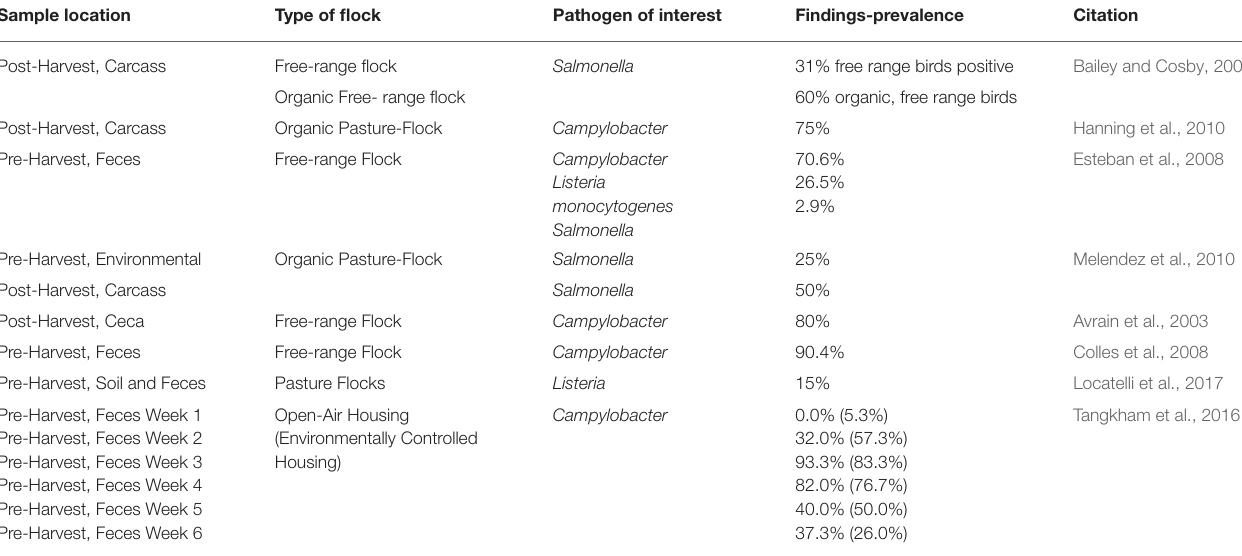
TABLE 1 | Representative Studies of pathogens found in Free Range and Pasture